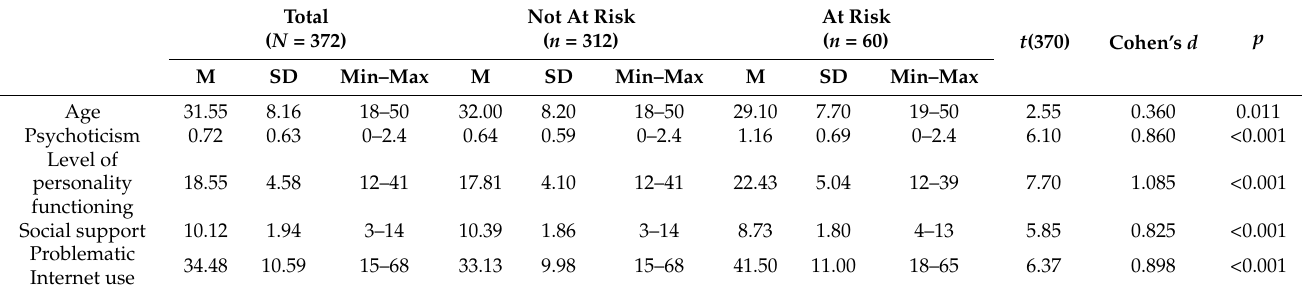
Table 4. Statistics for scales exploring psychological symptoms of all participants, participants not at risk for hikikomori (HQ-25 score below the cut-off score) and participants at risk for hikikomori (HQ-25 score equal or above the cut-off score).